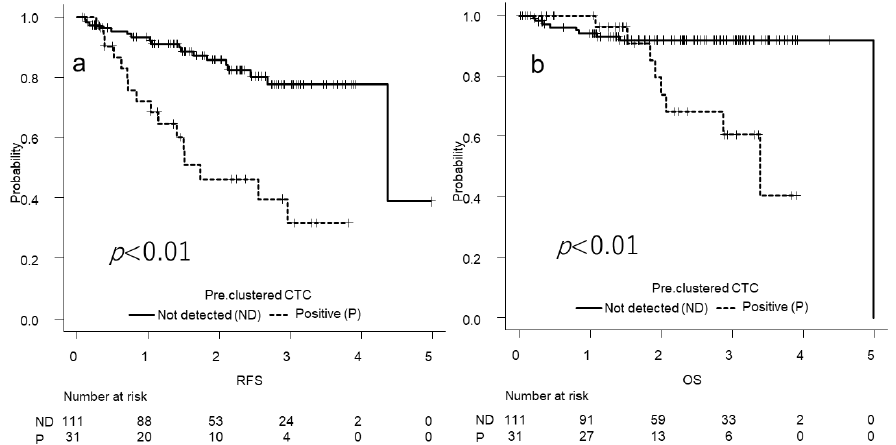
Figure 4. Survival curves according to the status of the circulating tumor cells. ( a ) The two-year RFS is 85.6% in the not detected (ND) cluster circulating tumor cell (CTC) ( n = 111) group and 46.3% in the cluster CTC-positive (P) group ( n = 31) ( p < 0.01); ( b ) the two-year OS is 91.7% in the ND group and 71.5% in the P group ( p < 0.01).